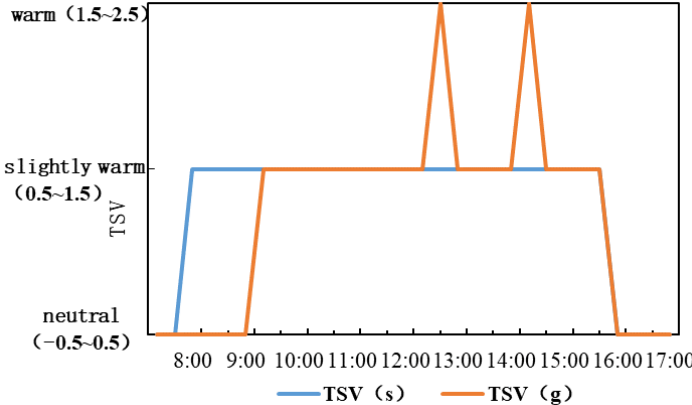
Figure 14. TSV calculation results of representative day in transition season.